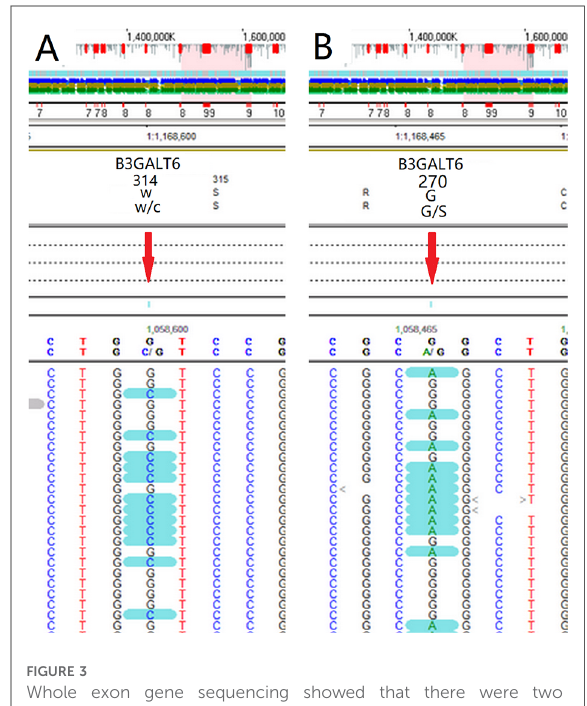
FIGURE 3 Whole exon gene sequencing showed that there were two